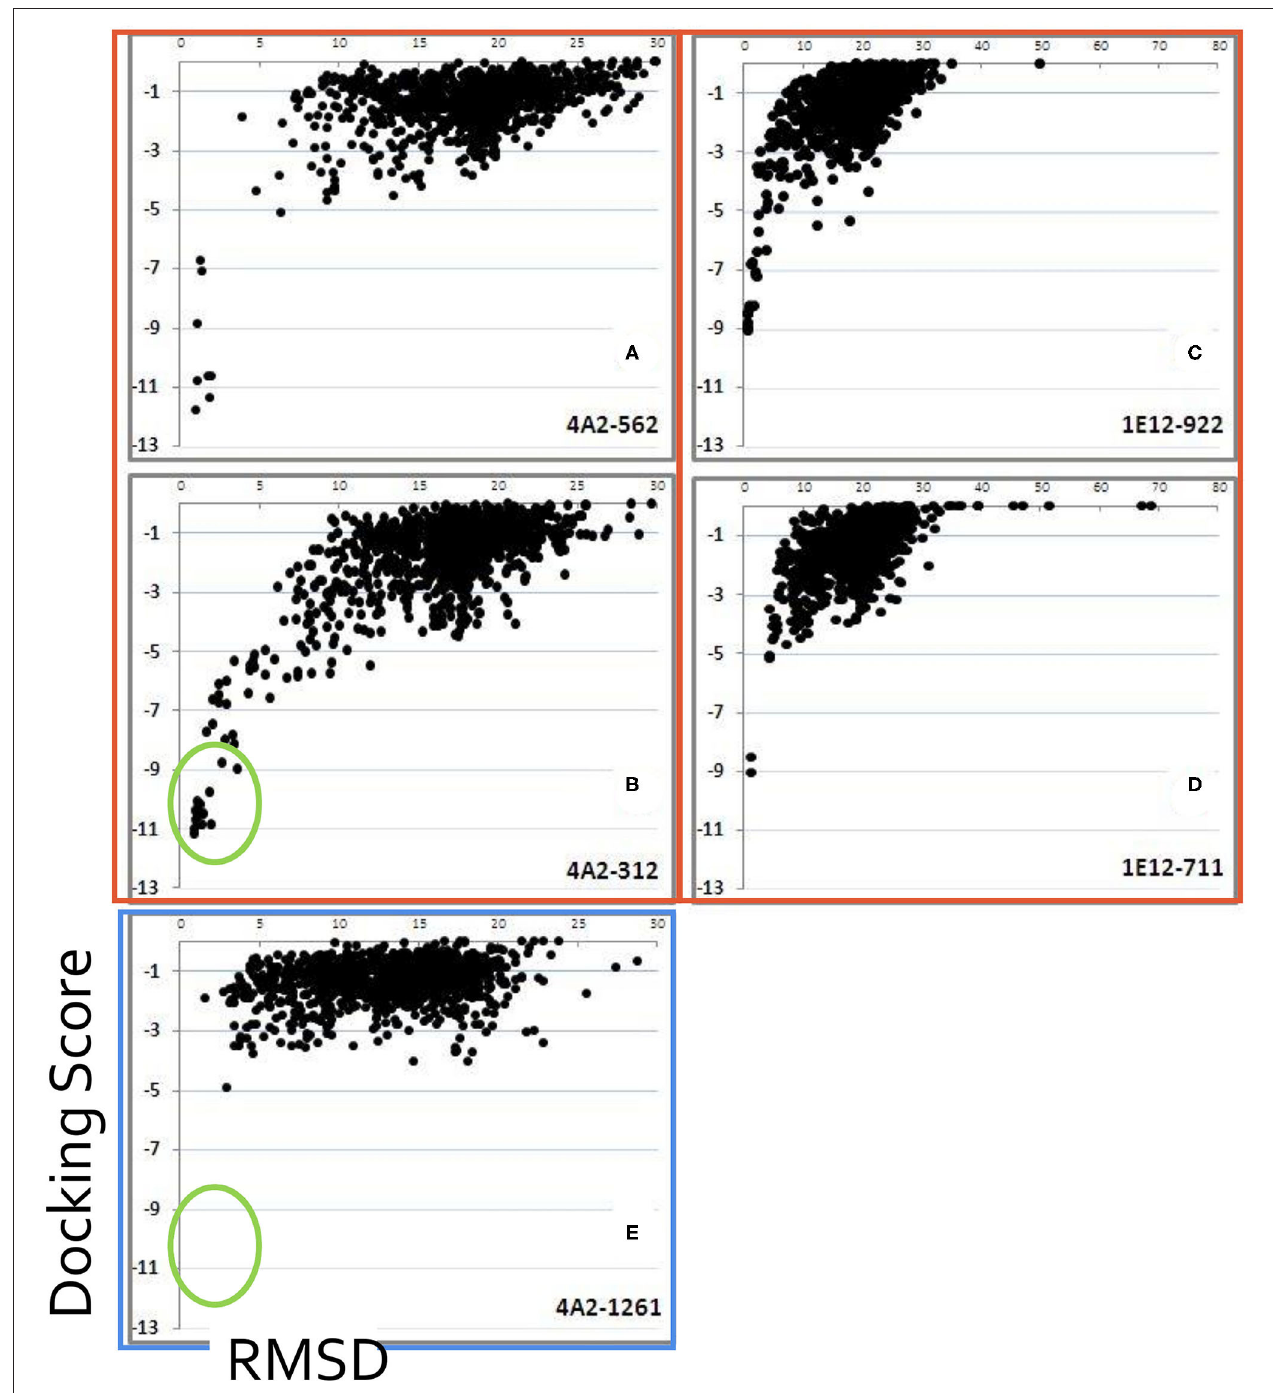
FIGURE 4 | Focused-docking experiments for candidate Ag–Ab complexes. Plots of five different docking experiments using mAb 1E12 or 4A2; dots composed by dG values (Docking score) vs. structural homology values (RMSD, on the horizontal axis). A characteristic pattern called energy funnel (A–D) , except for (E) , which was a negative control) emerges at near-native docking solutions. Green circles at (B,E) denotes the presence or absence of the energy funnel pattern.